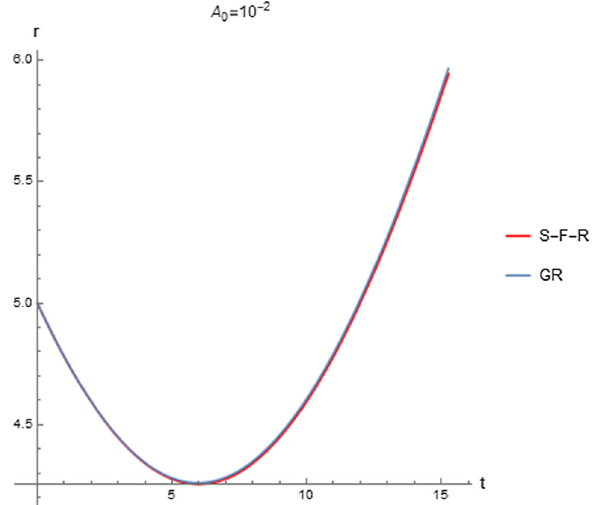
Fig. 5 This is an r-t graph of the timelike paths in the SFR model in comparison to the geodesics in GR for E = 1 . 2, L = 4, r 0 = 5 and ( a , b , c ) = ( 1 , 10 , 10 )